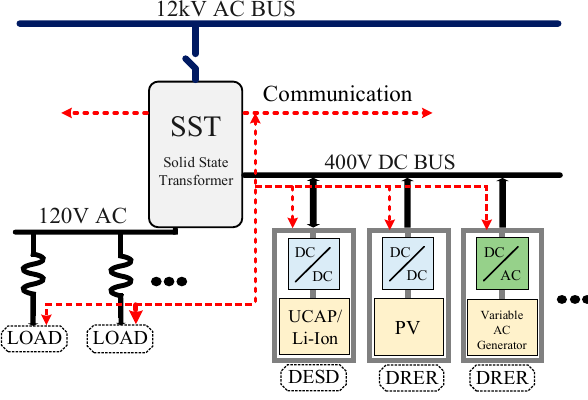
Figure 1. Solid–State Transformer at one residential home. When a 60 Hz conventional transformer cannot be utilized to control distributed renewable energy resources (DRER), distributed energy storage devices (DESD), or loads, voltage sag compensation, fault isolation, power factor correction, harmonic isolation,